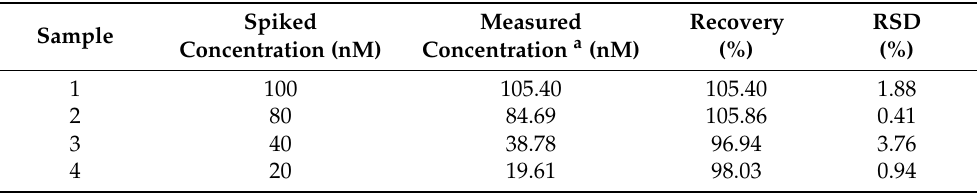
Table 2. Determination of thiamethoxam pesticide in spiked real